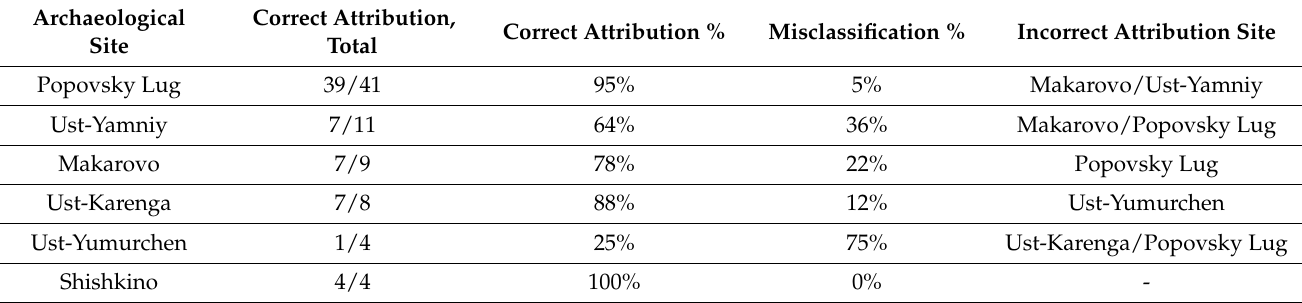
Table 4. Differentiation of ceramic samples by archaeological site based on the results of SVM.